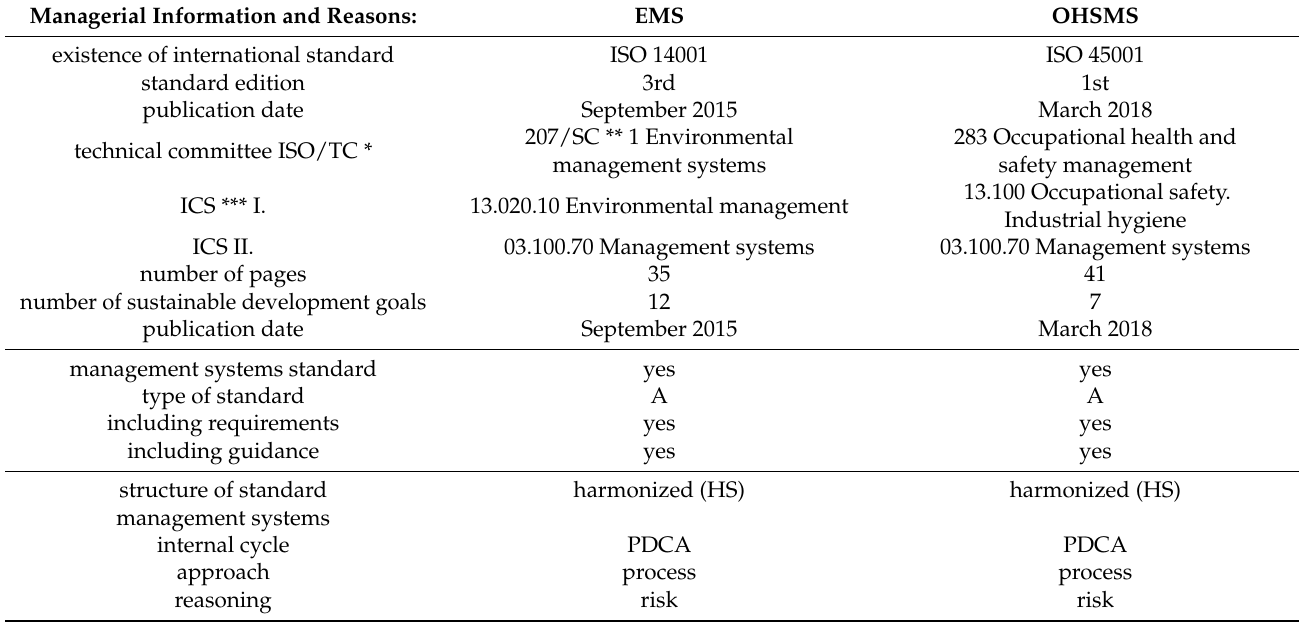
Table 2. The managerial reasons for the modeling and application of the EMS and OHSMS